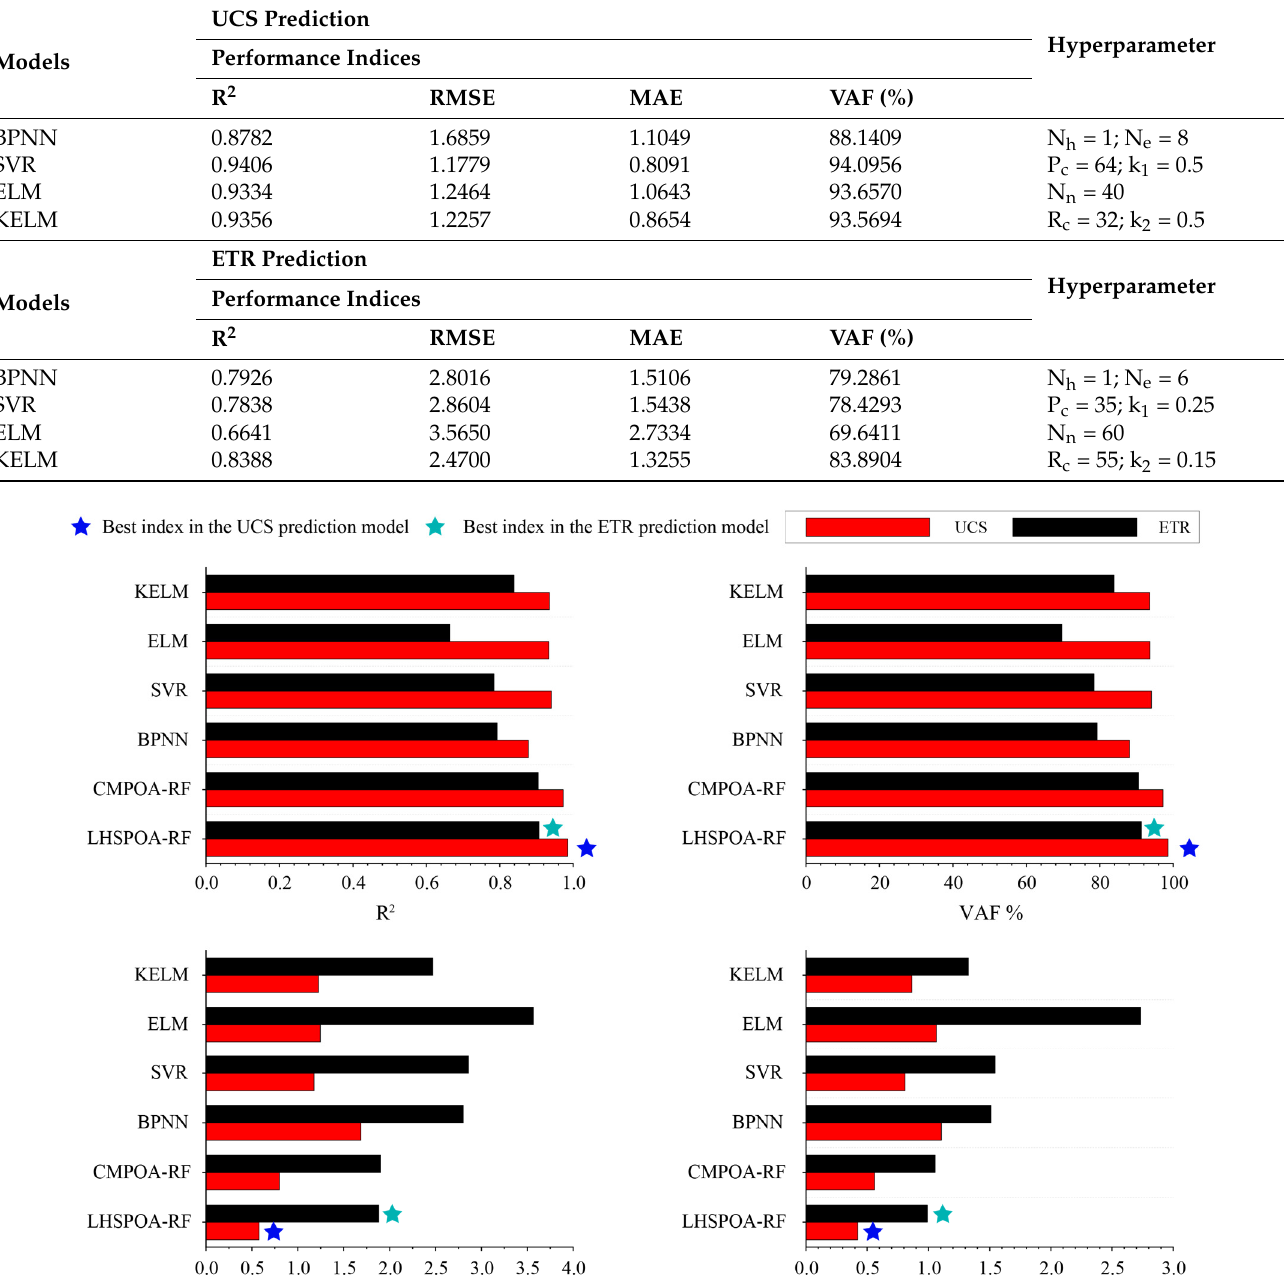
Table 8. The performance of the other four AI models using test set.